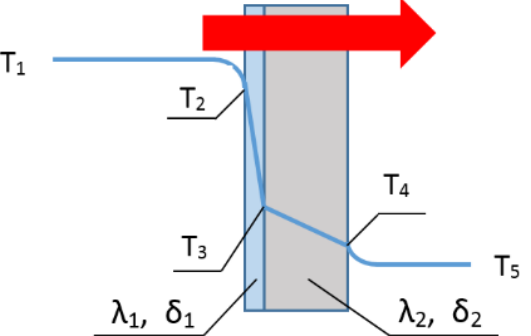
Figure 4. Temperature distribution in a two-layer measuring partition. Designations: δ 1 — thickness of heat reflective covering layer, λ 1 — heat conductivity coefficient of heat reflective covering layer, δ 2 — thickness of plasterboard wall partition, λ 2 — heat conductivity coefficient of plasterboard wall construction layer, T 1 —temperature inside the “hot box”, T 5 —temperature outside the “hot box”, T 2 , T 3 , T 4 — temperature at the junction of layers.